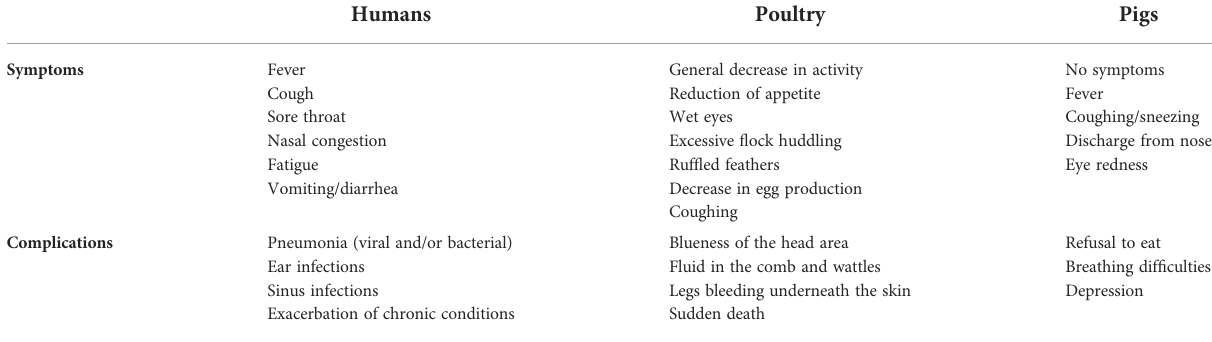
TABLE 2 Common fl u vs . avian fl u, symptoms and complications in humans, poultry, and